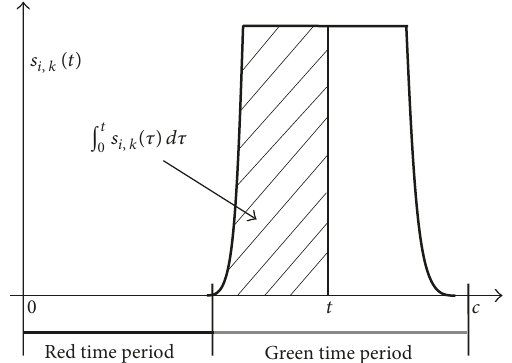
Figure 1: Typical traffic arrivals and cumulative arrivals (in number of vehicles or pcu) in an approaching traffic lane under traffic signal controls.